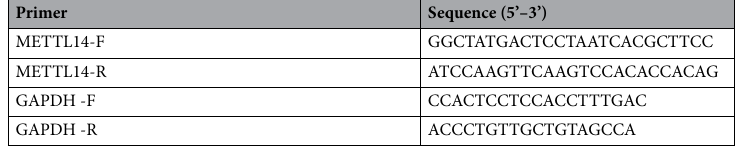
Table 2. Primer sequences for GAPDH and METTL14. Table shows the primer sequences for GAPDH and METTL14 during the primer design